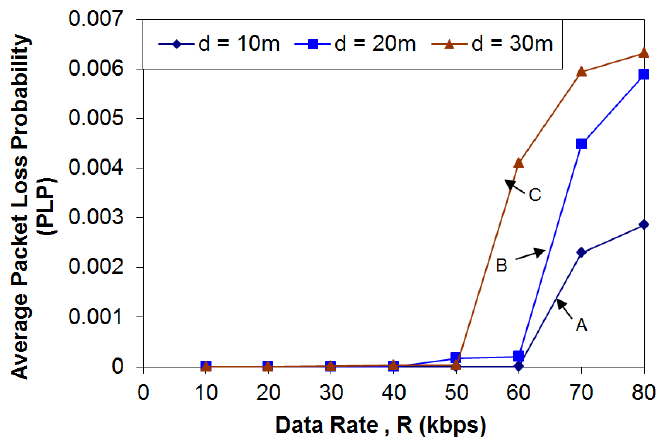
Figure 12. ZIPMS packet loss probability when d is 10–30 m and R is 10–80